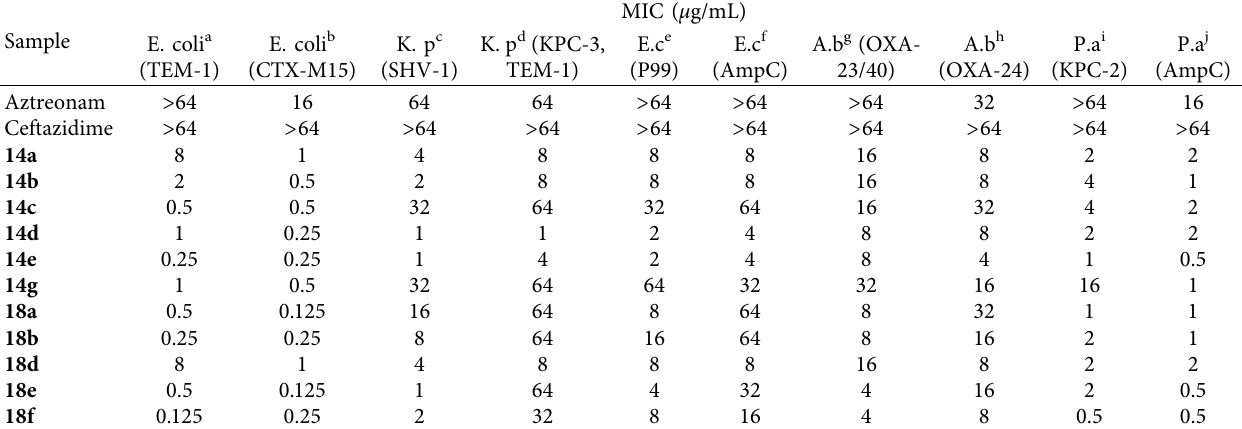
Table 1: In vitro antibacterial activities of monobactam derivatives 14 and 18 against selected Gram-negative bacteria.